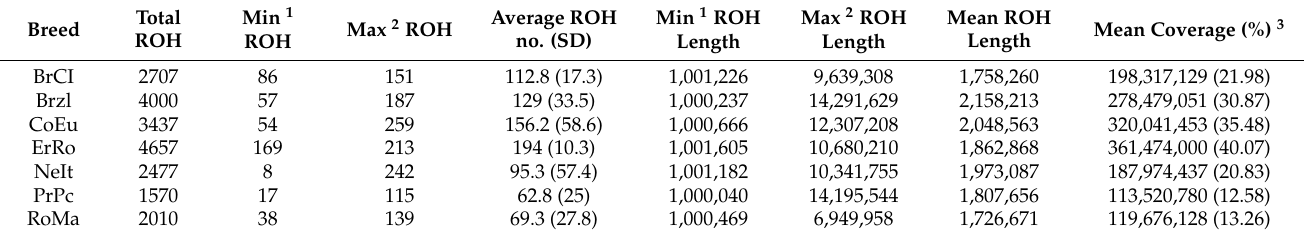
1 Min: minimum; 2 Max: maximum; 3 mean length covered by ROH (proportion of genome—defined by the SNP dataset— covered by ROH).